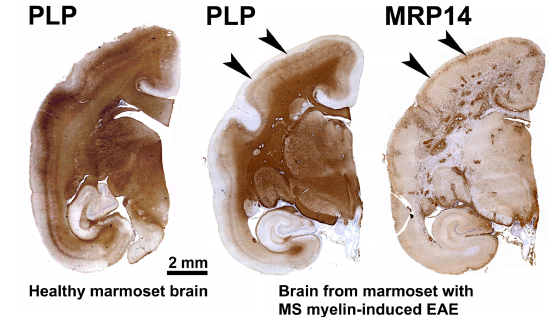
Figure 3. Characteristic brain pathology of marmoset EAE in- duced with human MS myelin/CFA. One brain hemisphere was im- munostained for PLP to visualize demyelination and for MRP14 (macrophages/microglia) to visualize inflammation. For compari- son, a brain hemisphere of a healthy marmoset was stained for PLP. Clearly visible is the different pathological aspect of white and cor- tical grey matter